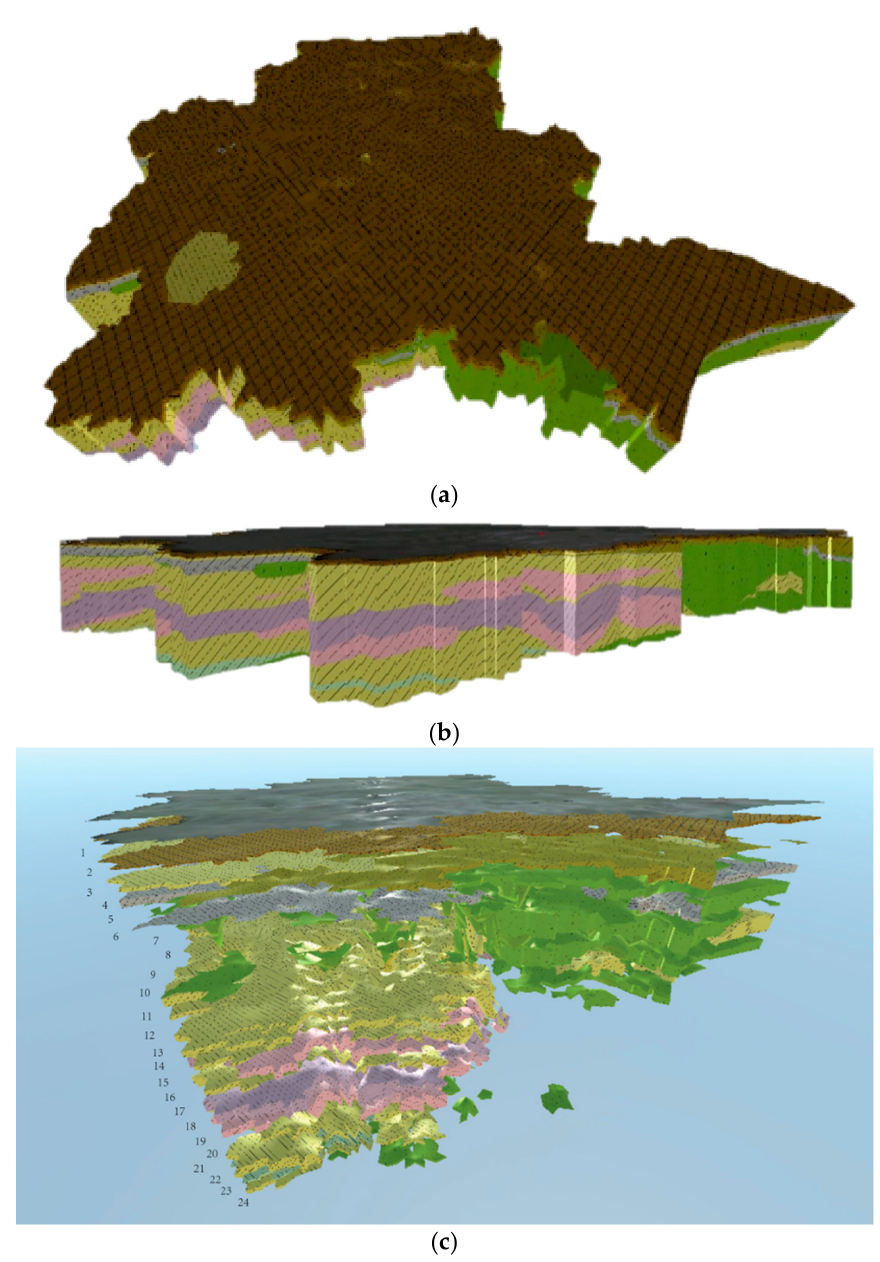
Figure 7. Model renderings. ( a ) Overall angle of the geological model; ( b ) side orientation of the geological model; ( c ) separated geological units’ layers.